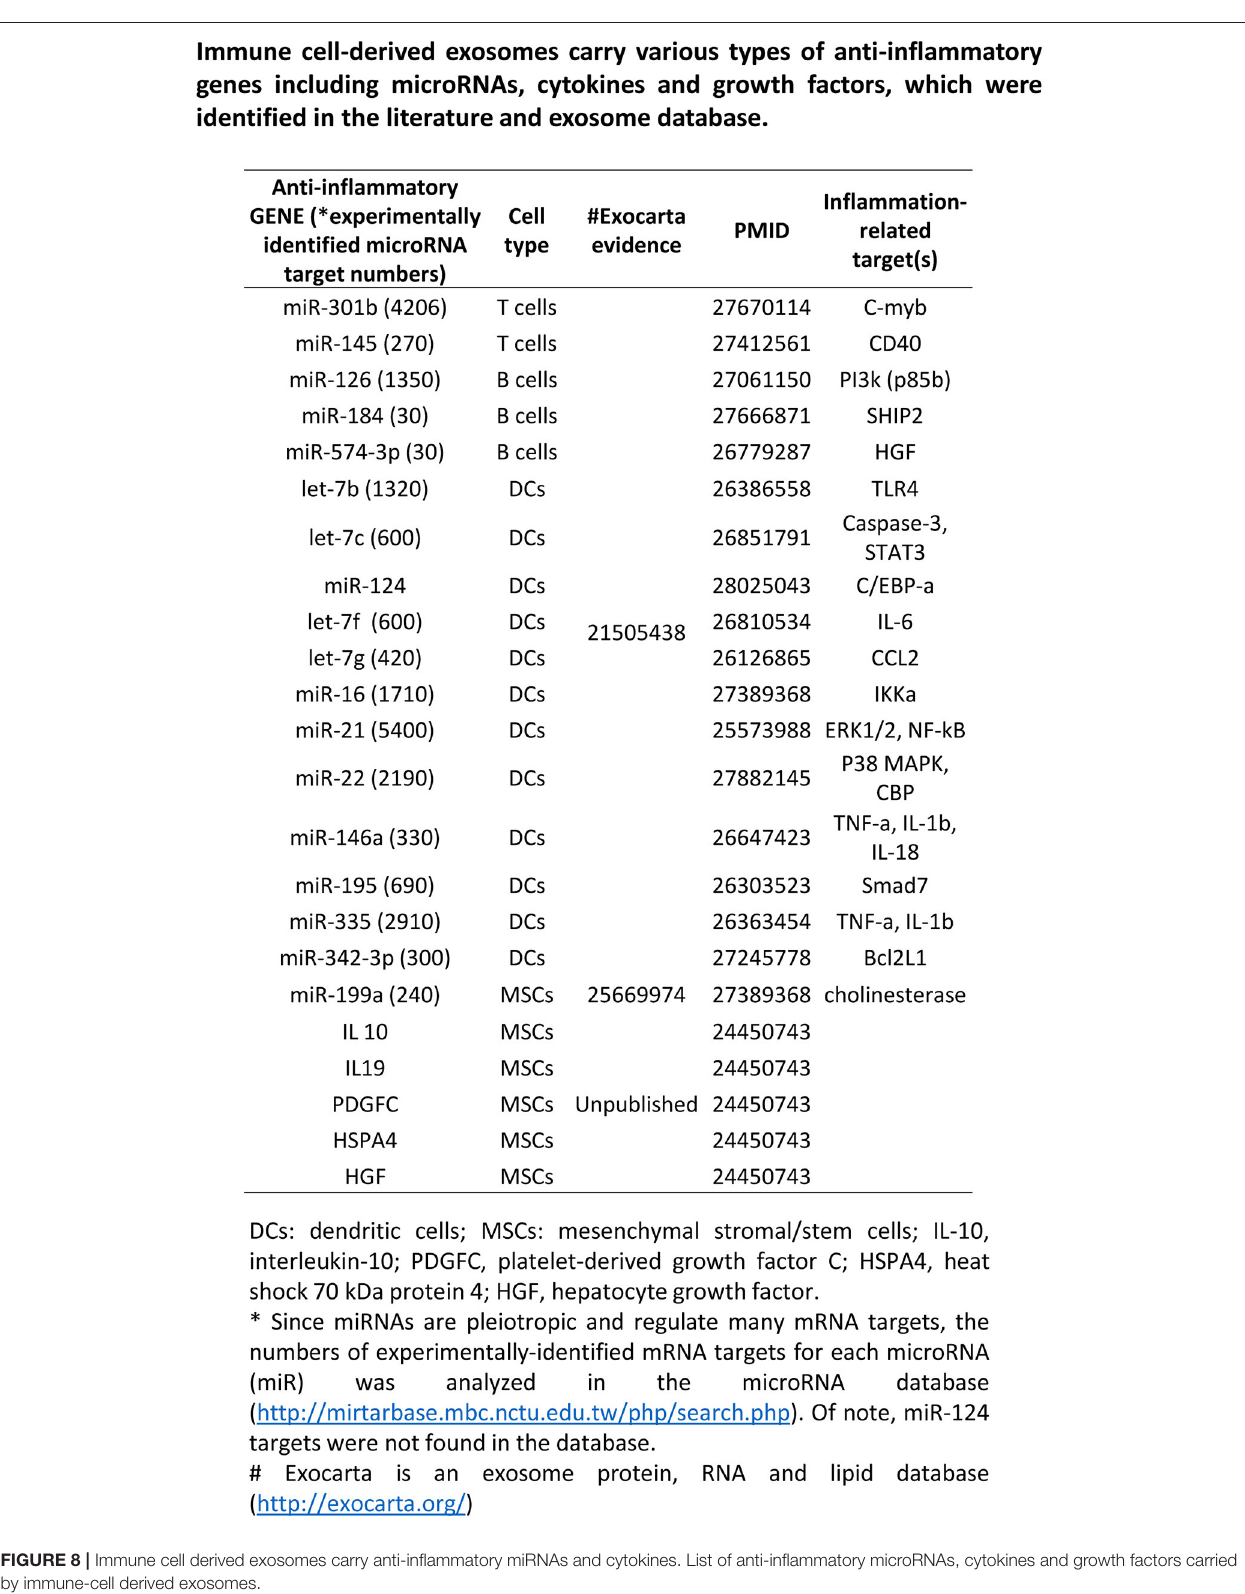
FIGURE 8 | Immune cell derived exosomes carry anti-inflammatory miRNAs and cytokines. List of anti-inflammatory microRNAs, cytokines and growth factors carried by immune-cell derived exosomes.